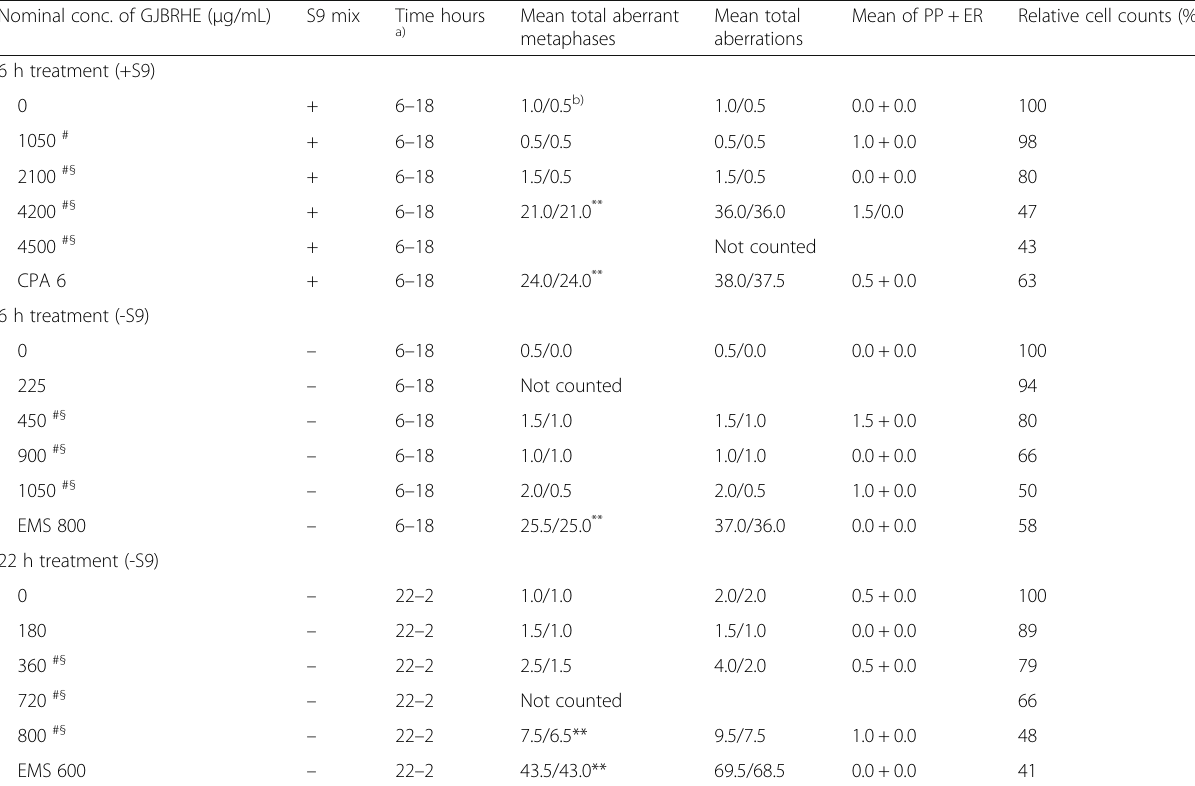
Table 3 Chromosome aberration assay and relative cell counts of Gyejibokryeong-hwan aqueous extract (GJBRHE) Nominal conc. of GJBRHE ( μ g/mL)